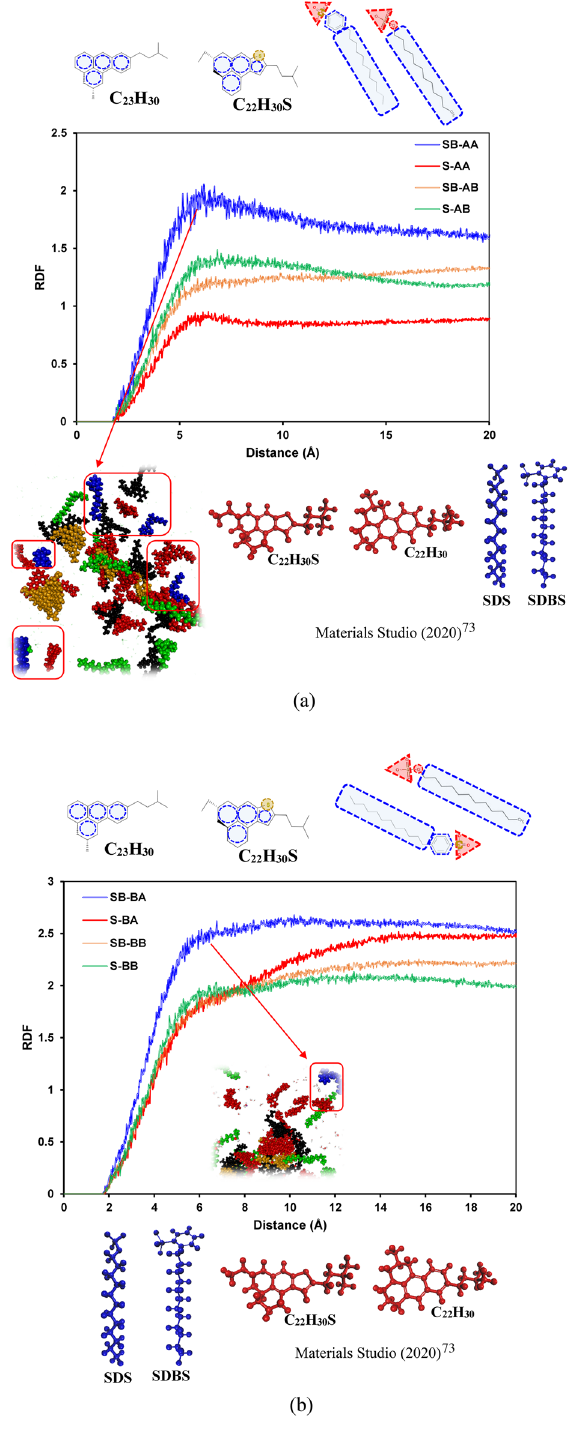
Figure 6. RDFs of the resin–surfactant molecule pairs containing ( a ) C 40 H 30 O 2 and ( b ) C 44 H 40 N 2